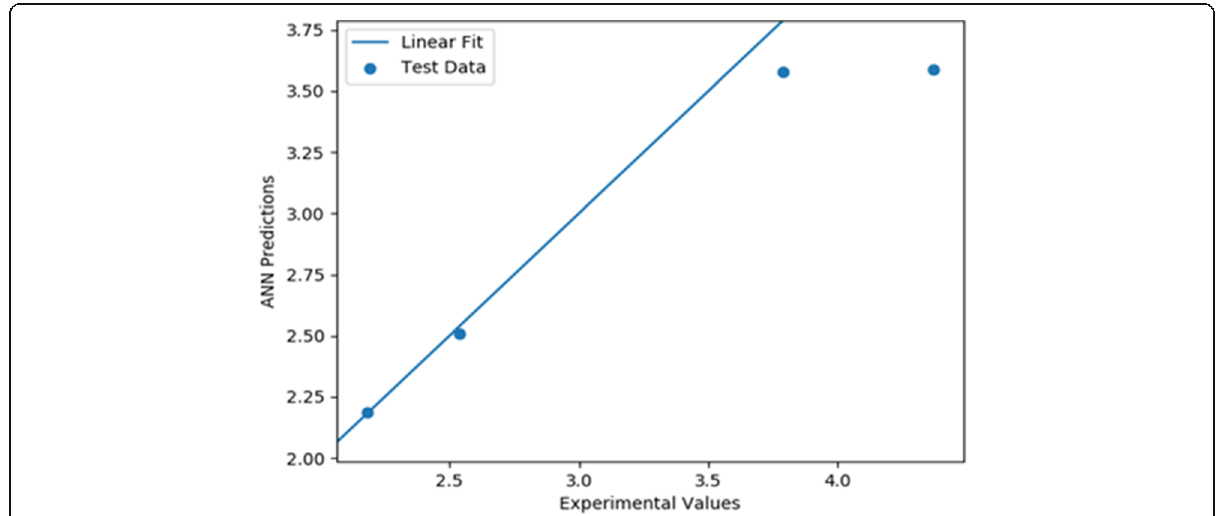
Fig. 10 Linear fit for the results of test data from ANN